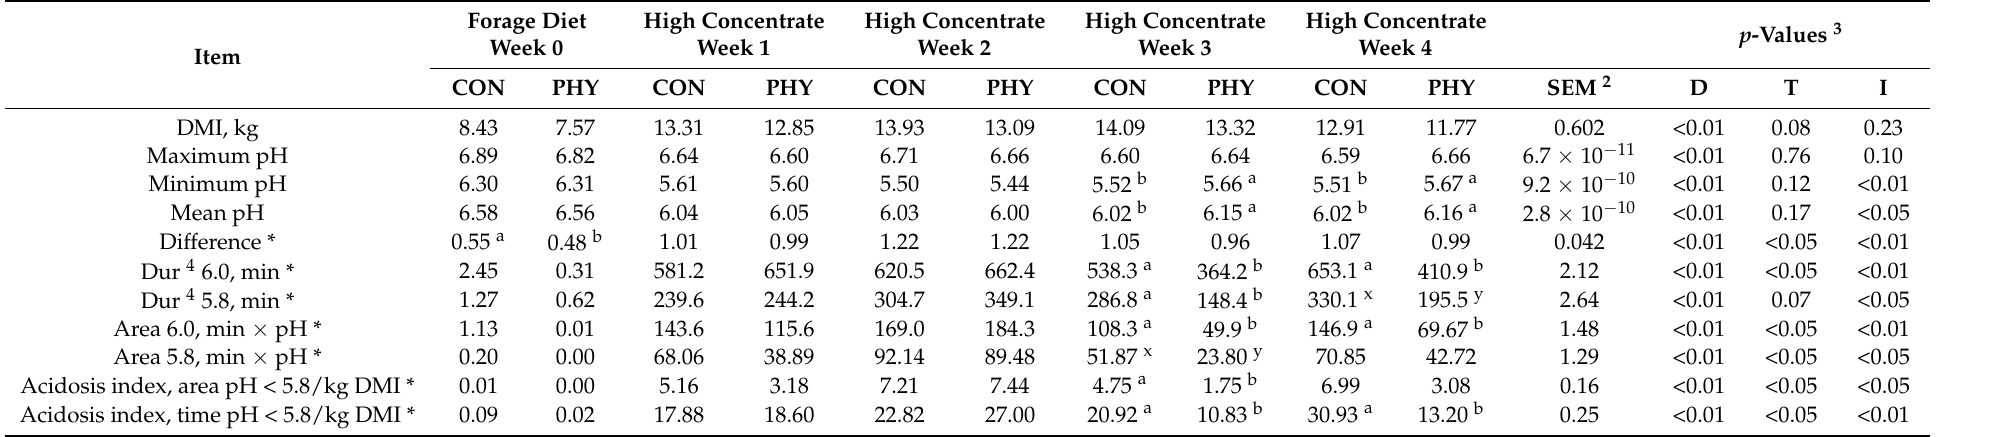
Table 2. Effect of supplementation with a phytogenic feed additive based on L-menthol, thymol, eugenol, mint oil ( Mentha arvensis ) and cloves powder ( Syzygium aromaticum ) on ruminal pH parameters in cows consuming a forage diet or a high concentrate diet 1 .